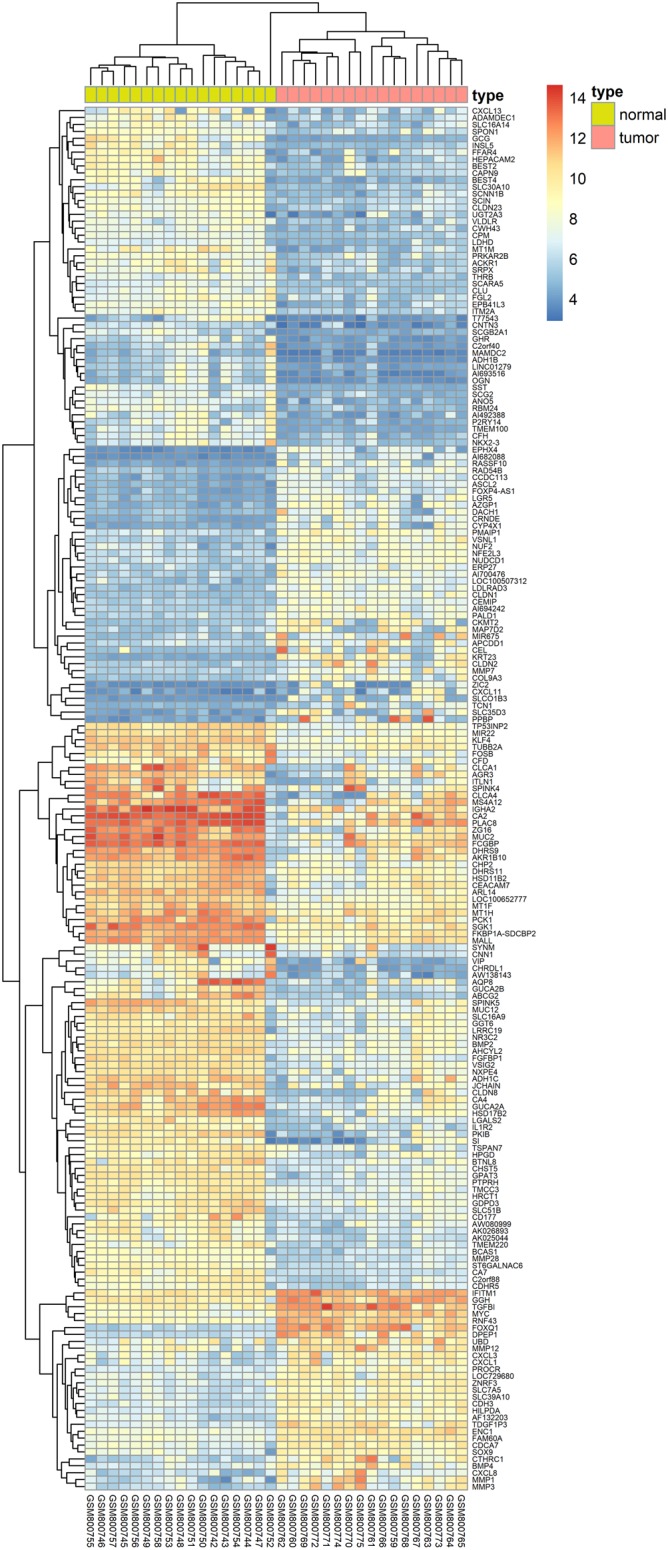
Identification of colon cancer-related targets using pre-existing microarray data. Two hundred DEGs identified by the limma package were highly related to colon cancer. P < 0.05 and FC > 2 were considered cut-off values.